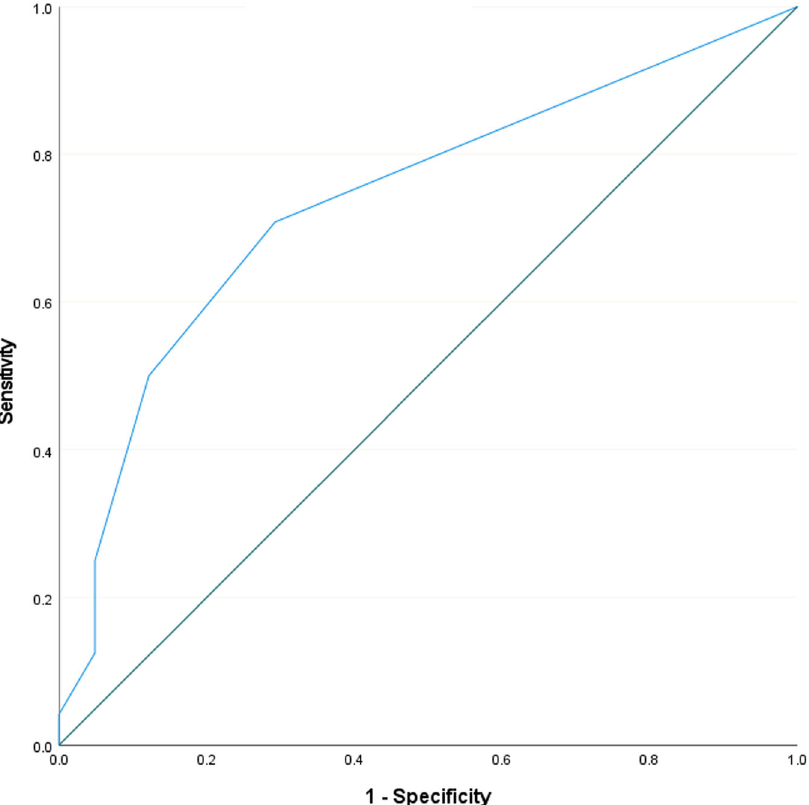
Fig. 2 Predicting Dysphagia for Medication. Receiver operating characteristic (ROC) curve with the sum score of the 2 swallowing-related Uni fi ed Parkinson ’ s Disease Rating Scale items predicting at least moderate overall dysphagia for